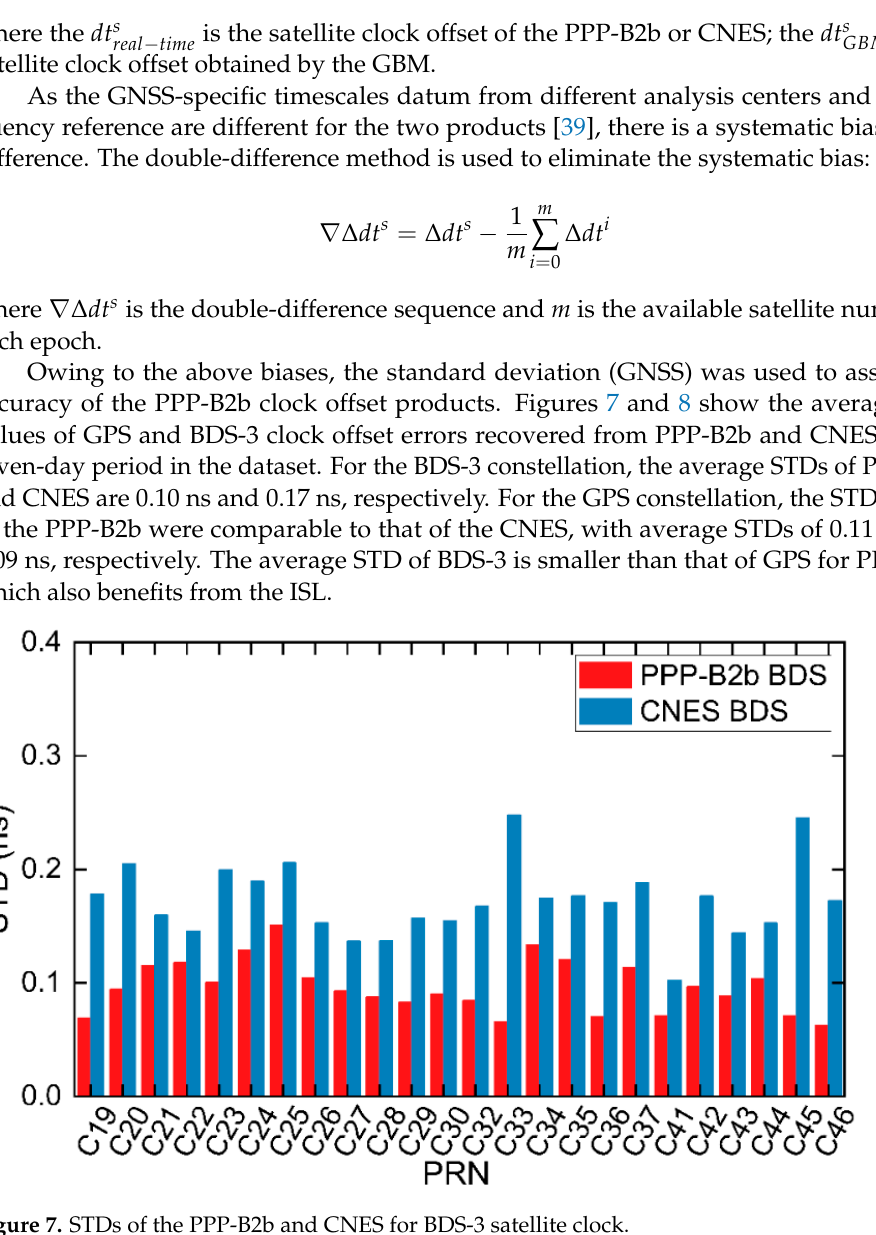
Figure 7. STDs of the PPP-B2b and CNES for BDS-3 satellite clock.